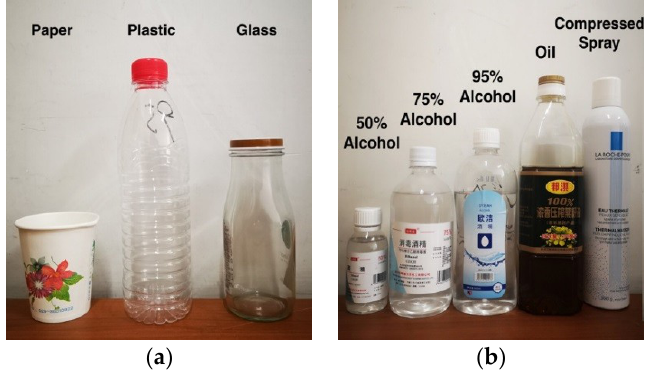
Figure 3. ( a ) The selection of containers; ( b ) Suspicious liquids selected from the experiment.